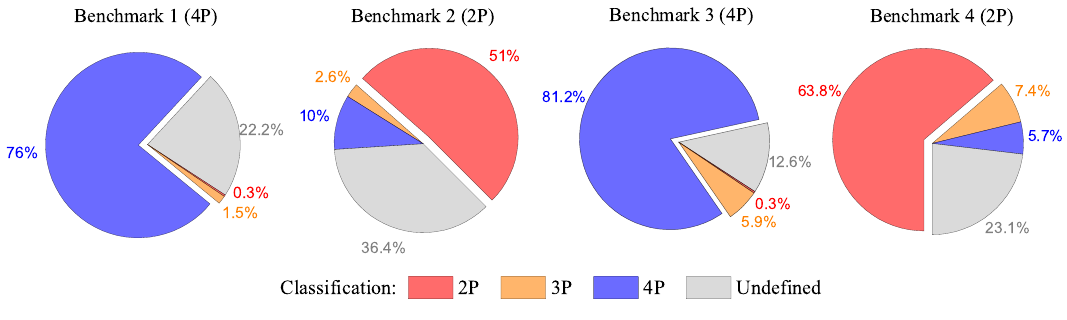
Figure 7 . Fraction of jets that are classified as 2P, 3P and 4P, or remain undefined, for the four benchmark examples described in the